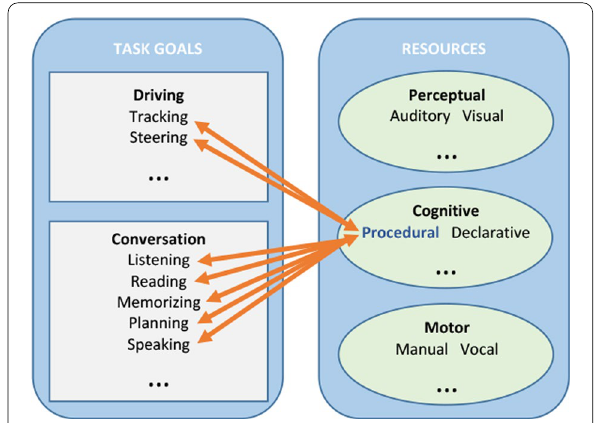
Fig. 11 Model of driving and conversation. Task goals and resources are coordinated, managed, and executed by a central procedural resource (following Salvucci & Taatgen,